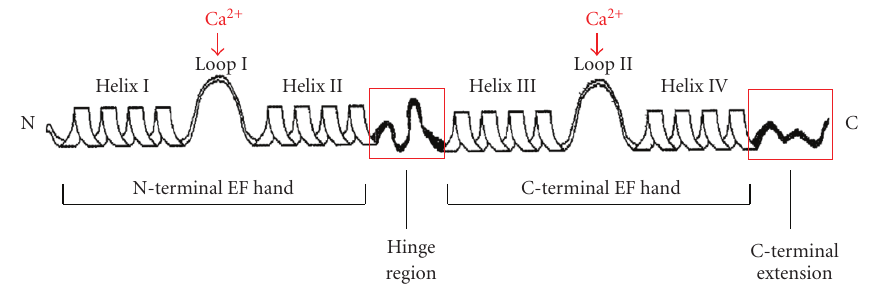
Figure 1: Schematic depiction of the secondary structure of an S100 protein. The monomeric structure consists of a repetitive EF-hand motif, whereas eachCa 2+ -binding Loop (Loop I and II) is flanked by α -helices. The N-terminal and the C-terminal EF hands are connected by a linker region (hinge region). The hinge region and the C-terminal extension (boxed in red) display the least amount of sequence homology among S100 paralogs. Reproduced with modifications from Donato [5].